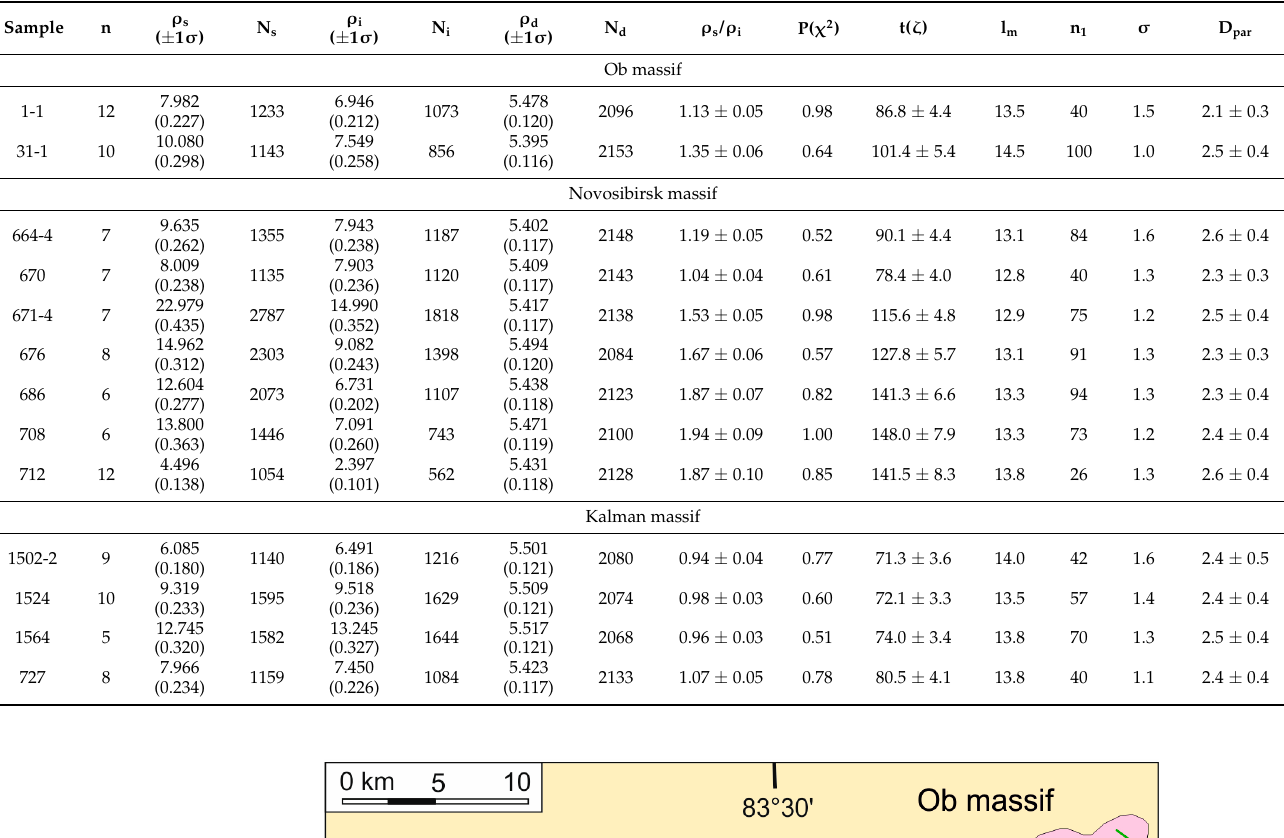
Table 2. Apatite fission track results: n is the number of analyzed grains; ρ s , ρ i (in 10 6 tracks/cm 2 ), and ρ d (in 10 5 tracks/cm 2 ) are the densities of spontaneous tracks in apatites, induced tracks in micas, and induced tracks in the dosimeter micas. N s , N i , and N d are the numbers of spontaneous tracks in apatite, induced tracks, and induced dosimeter tracks in the external detector, respectively. P( χ 2 ) is the chi-squared probability that the dated grains have a constant ρ s / ρ i -ratio. AFT ages (in Ma) are presented as AFT zeta-ages t( ζ ). A ζ -value of 281.6 ± 5.1 a · cm 2 was established based on analyses of Durango and Fish Canyon Tuff age standards and IRMM-540 dosimeter glass. l m (in µ m) is the mean horizontal (or corrected for dip angle) track length, σ (in µ m) the standard deviation, and n l is the number of measured horizontal confined tracks. Measurements of the kinetic parameter D par ( ± the standard deviation) are given in µ m.